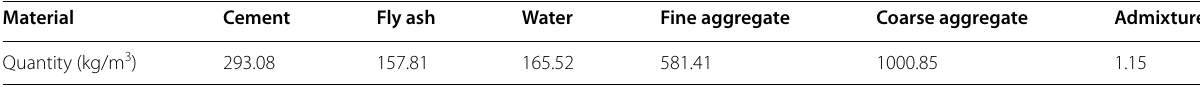
Table 1 Concrete mix composition